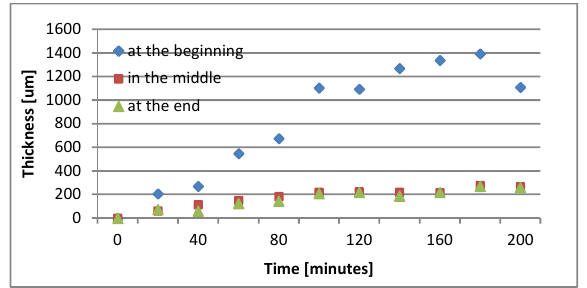
Fig. 10. Comparison of fouling layer thickness at different locations along a hollow fiber membrane vs time (50 cm fiber length, CFV 18 mm/s).